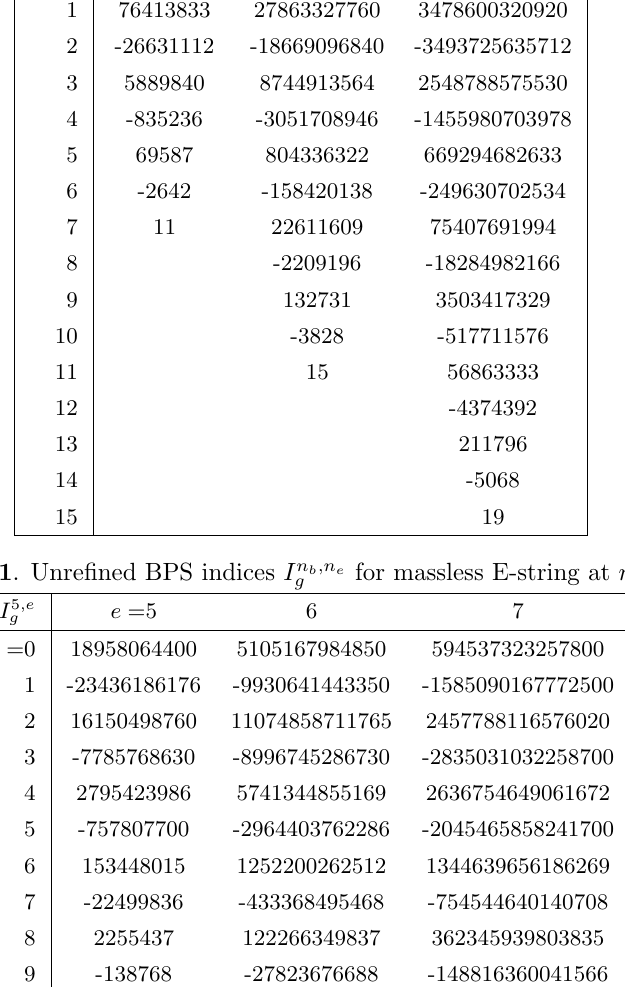
for massless E-string at n b = 4. g